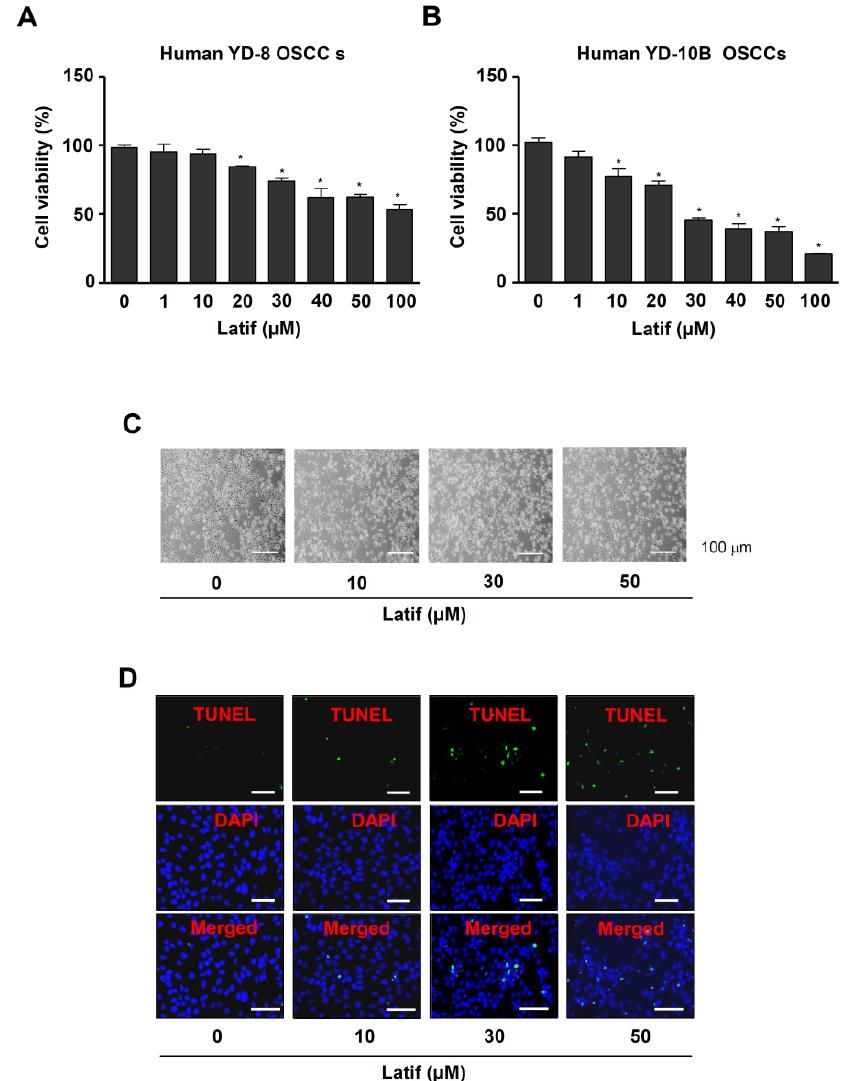
Figure 2. Effects of Latif on proliferation and apoptotic alteration in human OSCCs. ( A , B ) Cell viability was assessed after Latif treatment for 24 h at concentrations ranging from 0 to 100 µ M in human YD-8 and YD-10B OSCCs using an MTT assay. ( C ) Amounts of 10, 30, and 50 μ M Latif was treated for 24 h in YD-10B OSCCs, and apoptotic morphological changes were monitored under a light microscope. ( D ) Nuclear apoptotic DNA fragments were analyzed by TUNEL and DAPI staining and monitored under a fluorescence microscope. Scale bar: 50 μ m. Data are represented as mean ± S.E.M. Significance was set at p < 0.05, indicated by an asterisk in the graph.